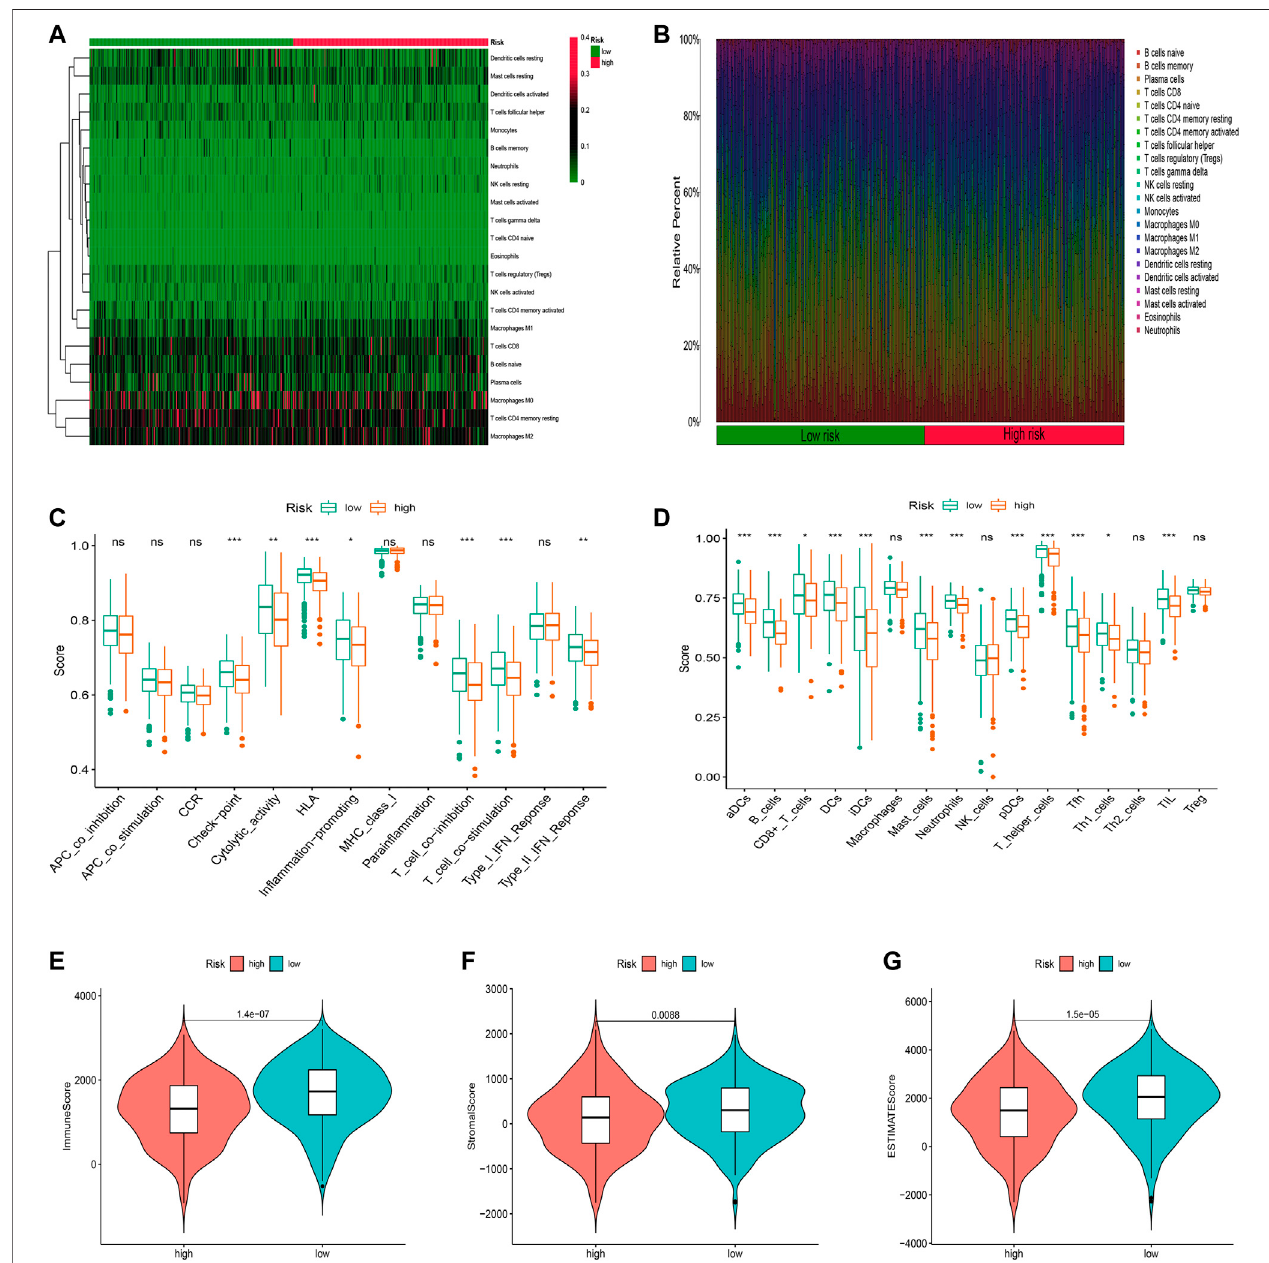
FIGURE 8 | Immune in fi ltration discrepancy in different risk groups. (A) Heatmap of 22 tumor-in fi ltrating immune cell types in low- and high-risk groups. (B) Bar chart of the proportions for 22 immune cell types. (C) ssGSEA scores of immune functions in low-risk and high-risk groups. (D) Immune cells in low-risk and high-risk groups. (E – G) TME scores between high- and low-risk groups. * p < 0.5, ** p < 0.01, and *** p < 0.001; ns, no